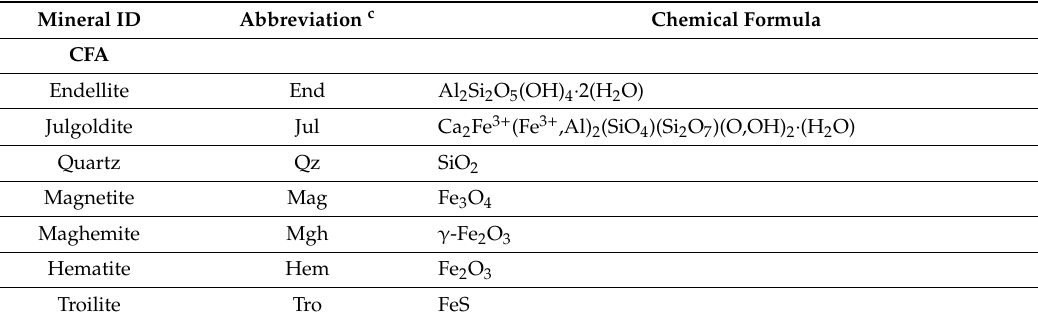
Figure 2. Mineralogical pattern (XRD) of raw materials ( a ) CFA and ( b ) NMW. Table 5. List of detected minerals for NMW and CFA.